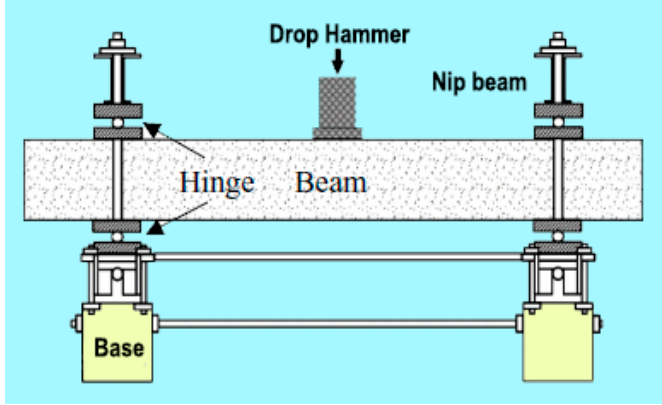
Figure 3. Drop hammer experiment process.